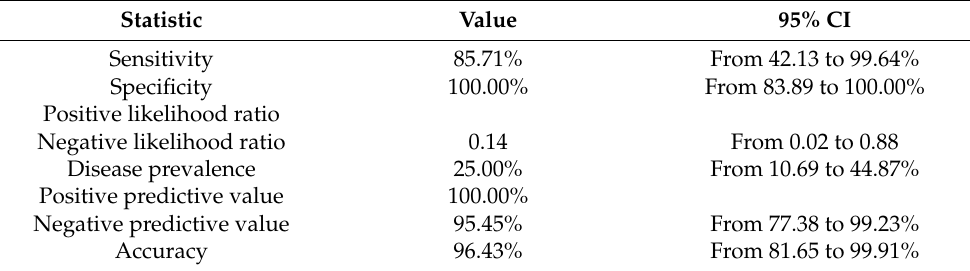
Table 6. Statistical analysis of preeclampsia prediction using the proposed LC-MS/MS method in the 24th week of pregnancy. CI—confidence